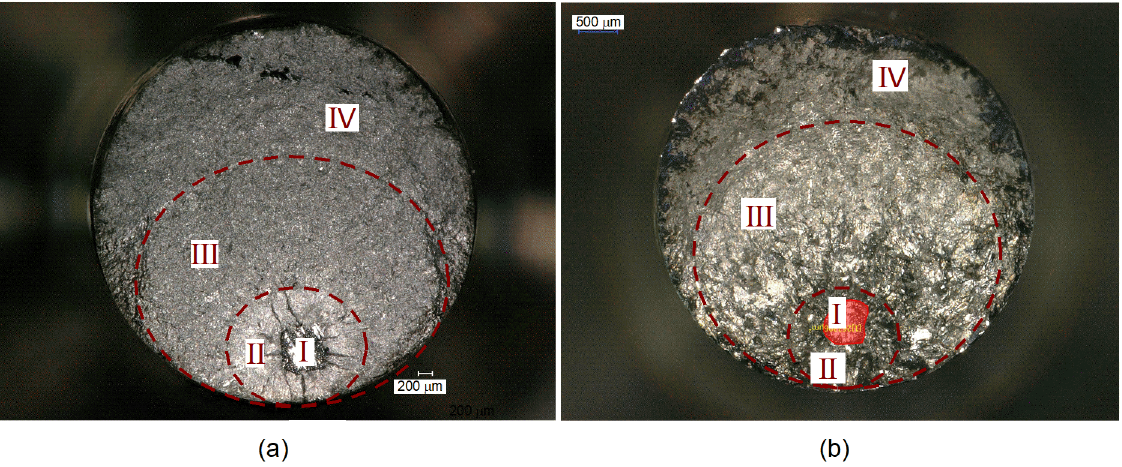
Figure 4. Characteristic fracture surface of Ti6Al4V ( a ) and Inconel 718 ( b ) coupons with a focus on the different crack propagation